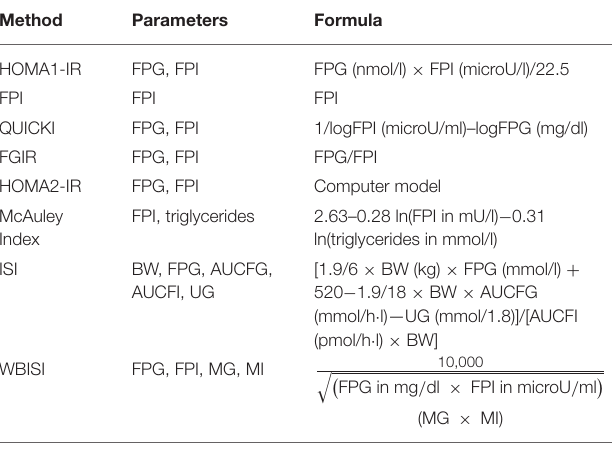
TABLE 2 | Main surrogate indexes of Insulin Resistance in children and adolescents.